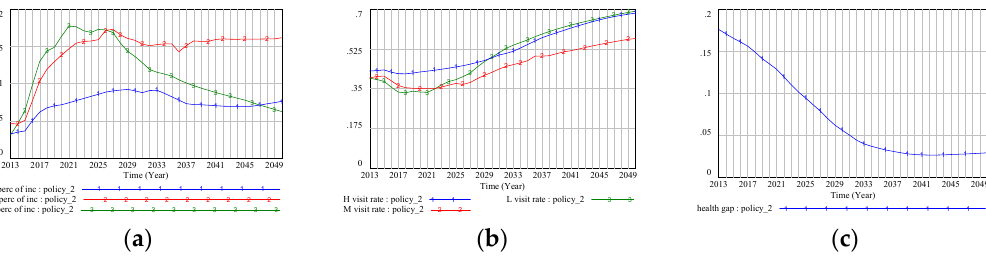
Figure 8. ( a ) Medical costs as a proportion of income (Policy Scenario 2); ( b ) doctor-visiting rate